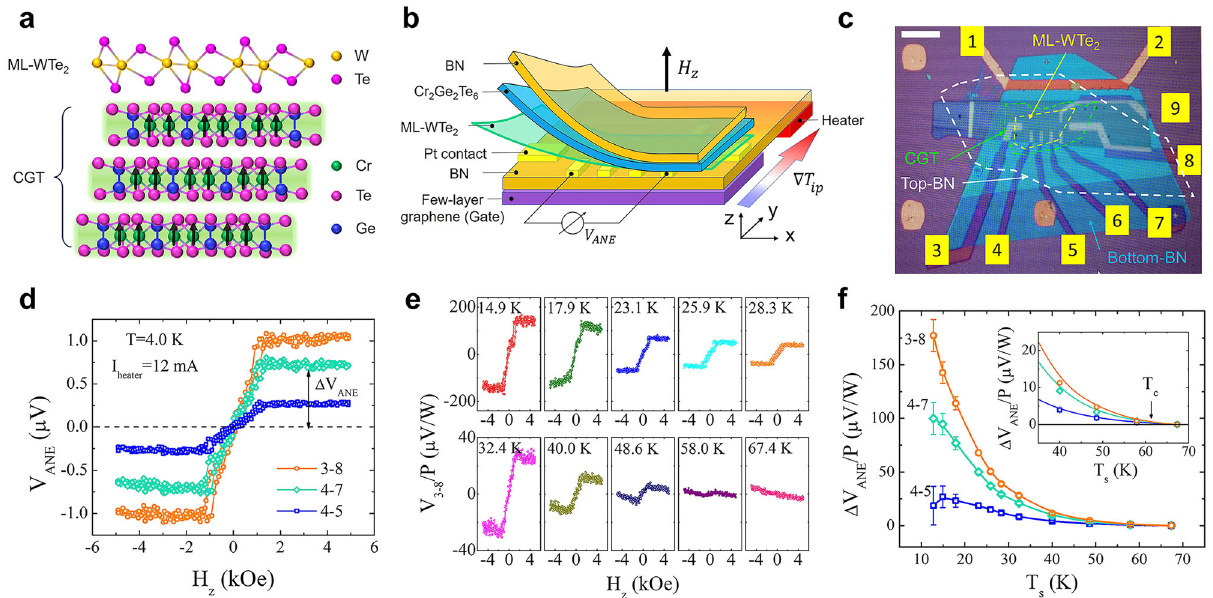
Fig. 1 | Device structureandanomalousNernstsignals in monolayer1T ’ WTe 2 / Cr 2 Ge 2 Te 6 heterostructure. a Schematic of monolayer (ML) 1T ’ WTe 2 /Cr 2 Ge 2 - Te 6 (CGT) vdW heterostructure. b Schematic of the ANE device structure. BN standsforhexagonalboronnitride.Thenonlocalheaterforgeneratingin-plane temperature gradient ∇ T ip is underneath the bottom BN. Open circuit voltage V ANE due to ANE is measured in sweeping out-of-plane magnetic fi eld H c Device optical image before transfer of ML-WTe 2 /CGT composite layer on pre-patterned Pt electrodes. The scale bar is 20 μ m . The polygons with yellow, green and white dashed boundaries indicate the pro fi les of ML-WTe 2 , CGT and top-BN, respectively. d Magnetic fi eld dependence of 20-loop averaged ANE